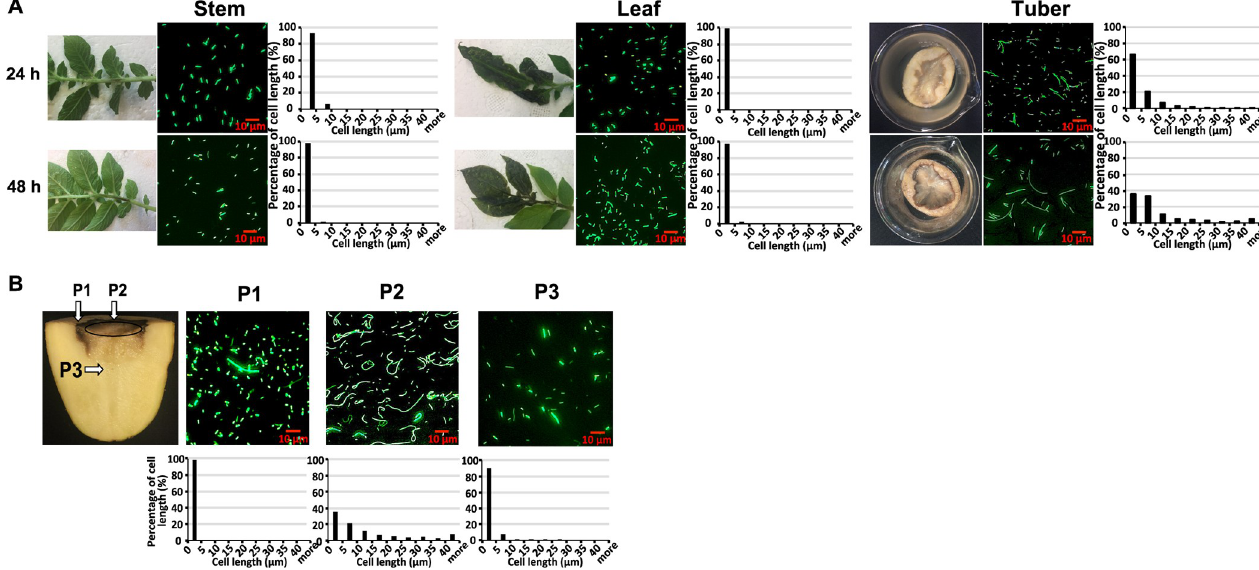
Fig 2. Impact of organ types and infection positions to the distribution of filamentous cells and short cells of D . dadantii on potato tubers. (A) Symptoms, cell morphology and length distribution of D . dadantii at 24 and 48 hpi on potato leaves, stems, and tubers and (B) after 48 hpi on potato tubers sampled at three different positions. Cells expressing green fluorescence were observed using an epifluorescence microscope. At least three randomly sampled views were analyzed for each sample and one of them was displayed in this figure. The three sampling positions on potato tubers are P1 (surface edge, at the interface of the rotten and healthy tuber tissue), P2 (surface center) and P3 (internal edge, at the interface of the rotten and healthy tuber tissue). Cell length was quantified by ImageJ. The experiment was repeated three times with similar results observed.